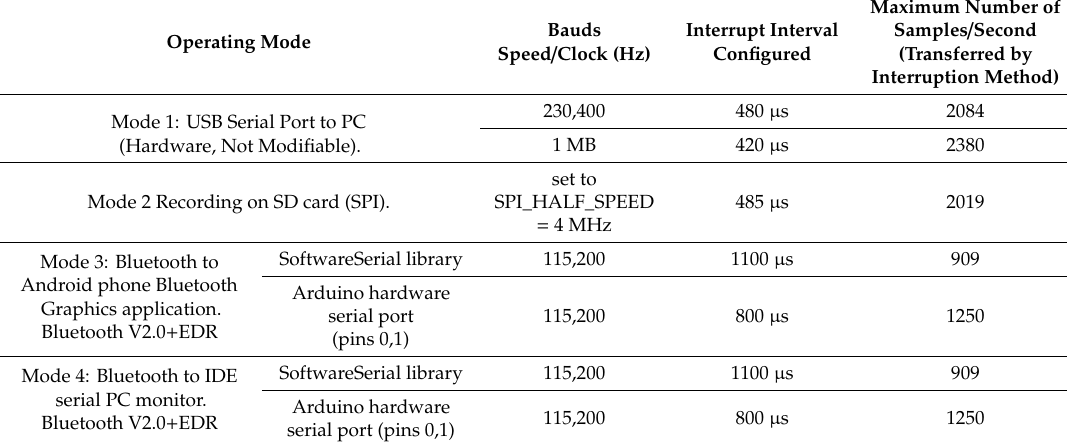
Table 9. Maximum data / second to avoid information loss in di ff erent operating